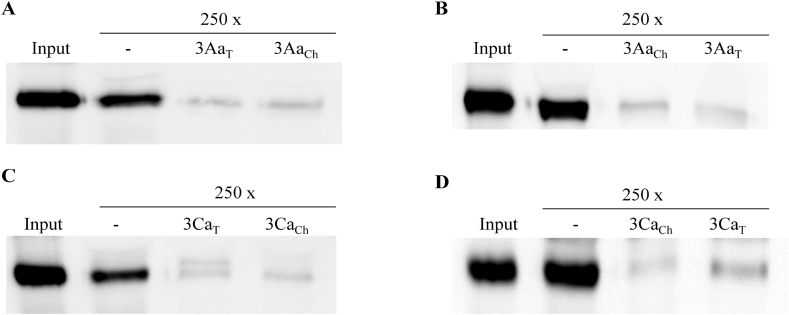
Homologous competition binding assays on C. puncticollis BBMV. Biotinylated trypsin or chymotrypsin-activated Cry3 proteins were incubated in absence (−) or presence (250x) of unlabeled trypsin or chymotrypsin-activated proteins. A, biotinylated trypsin-activated Cry3Aa (3AaT); B, biotinylated chymotrypsin-activated Cry3Aa (3AaCh); C biotinylated trypsin-activated Cry3Ca (3CaT); D, biotinylated chymotrypsin-activated Cry3Ca (3CaCh). Input indicates biotinylated Cry3 proteins.